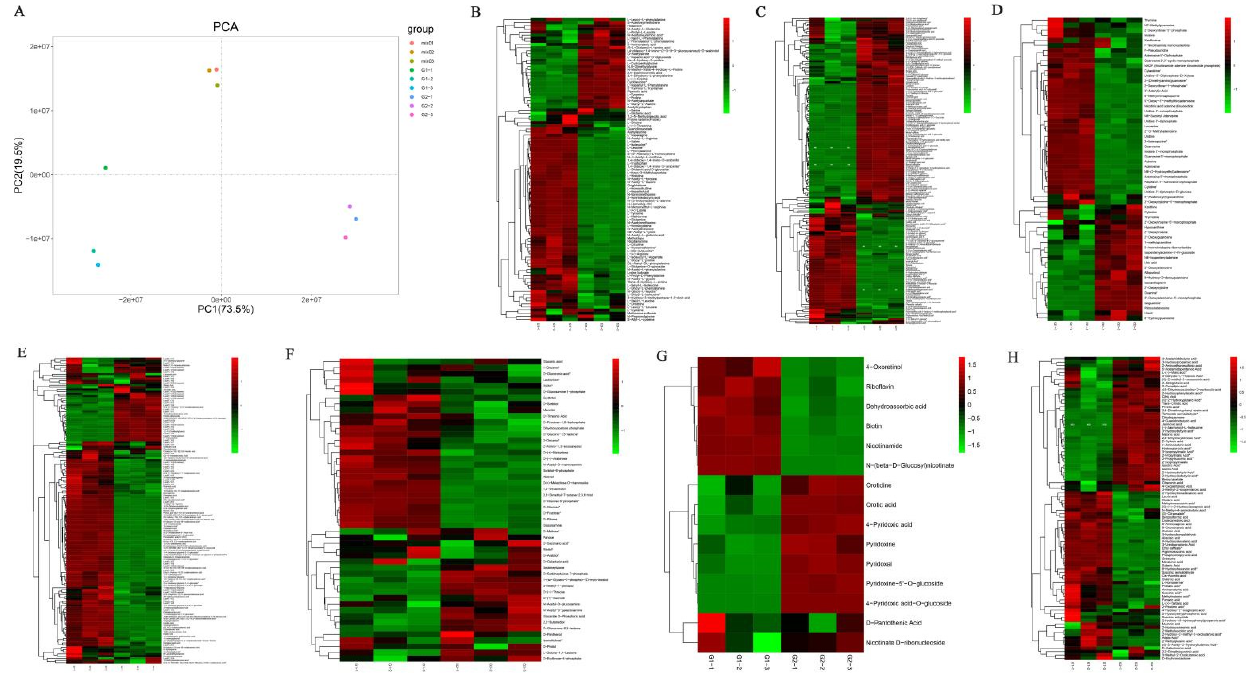
201 202 203 204